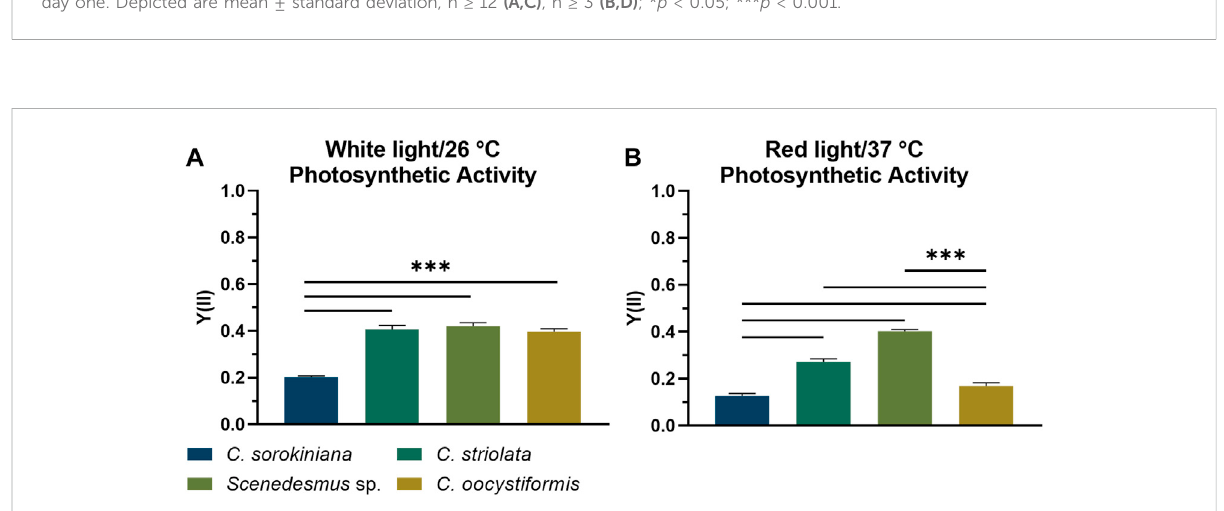
FIGURE 2 PAM induction curve measurement; averaged saturated effective photosynthetic yield Y(II) of the four microalgae strains in suspension culture under either white light illumination at 26 ° C (A) or red-light illumination at 37 ° C (B) after 3 days of cultivation in TP medium. Depicted are mean ± standard deviation, n = 5; *** p <